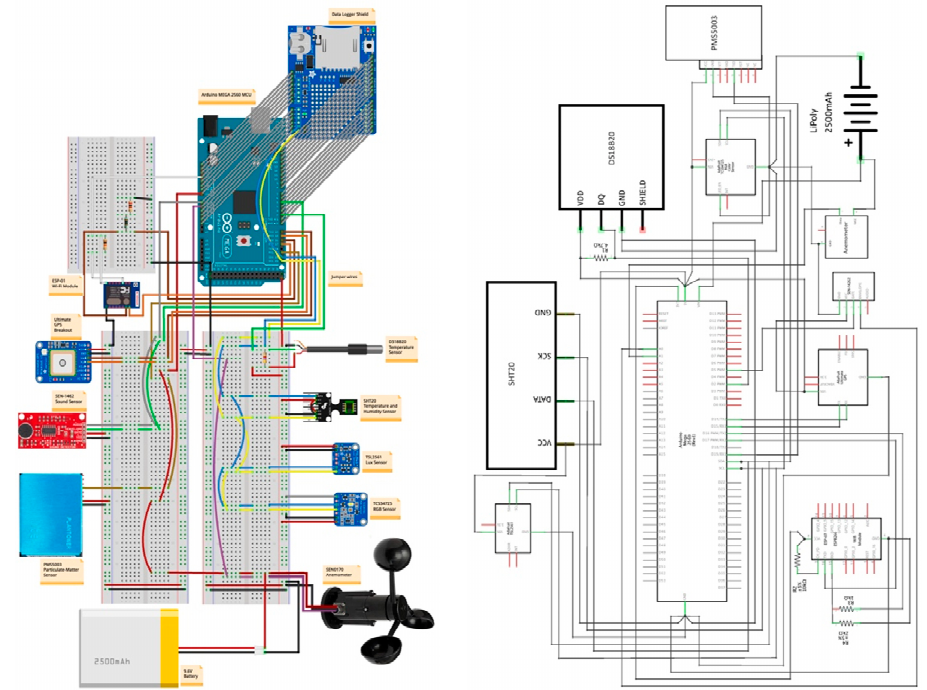
Figure 3. Wiring and schematic diagram of the conclusive model (Fritzing).